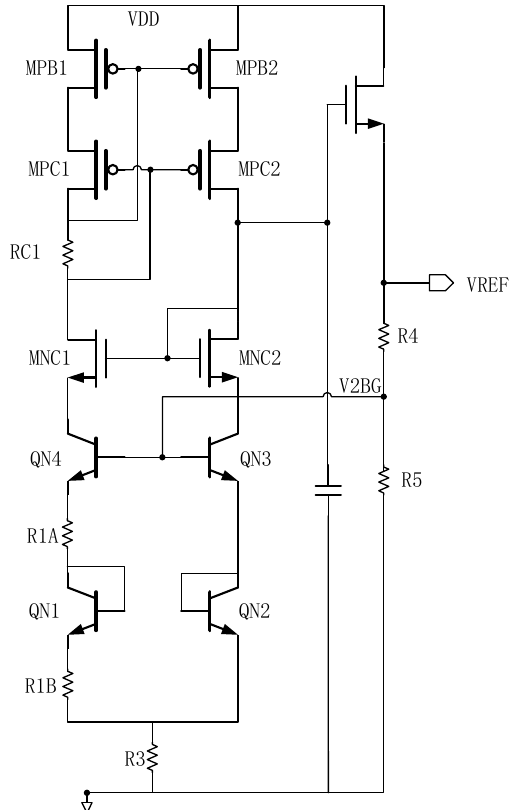
Figure 4. Proposed bandgap core diagram.